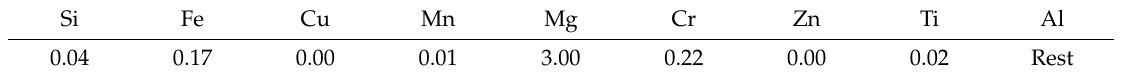
Table 1. Nominal composition of the 5754-aluminum alloy